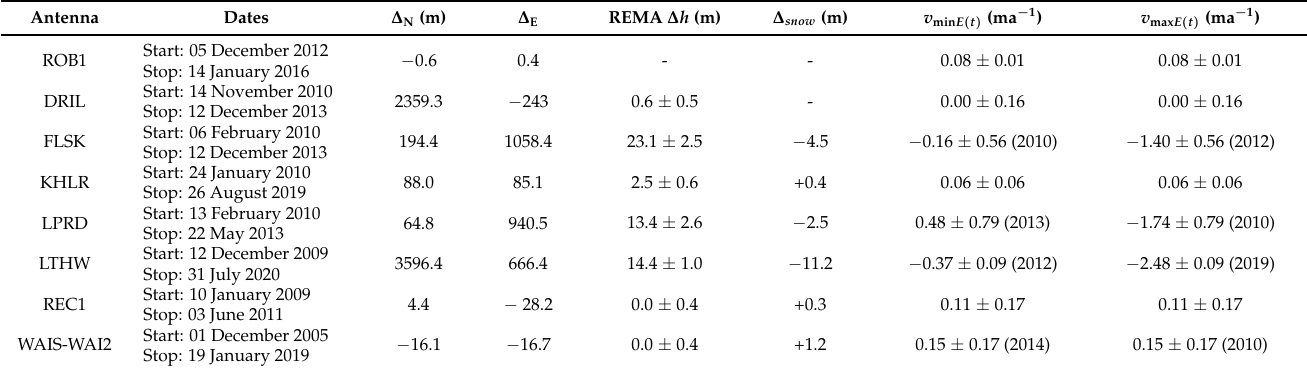
Figure 11. 2012 yearly maximum velocity of the Eulerian surface elevation. For comparison, LTHW Eulerian surface velocity for 2019 is reported on the left with an orange arrow. Table 3. Summary of antennas